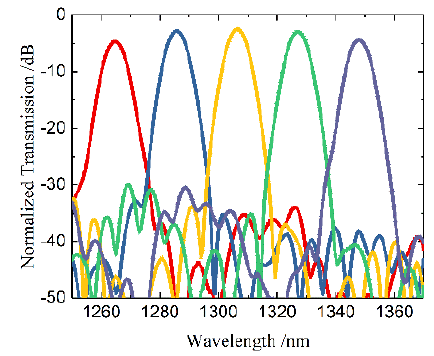
Figure 2. Layout schematic of the fabricated AWG device.